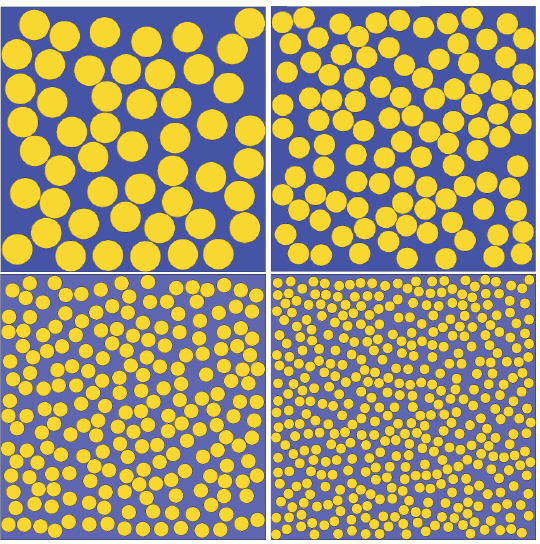
Figure 3: The generated random models with 50, 100, 200 and 400 fibers for v f =